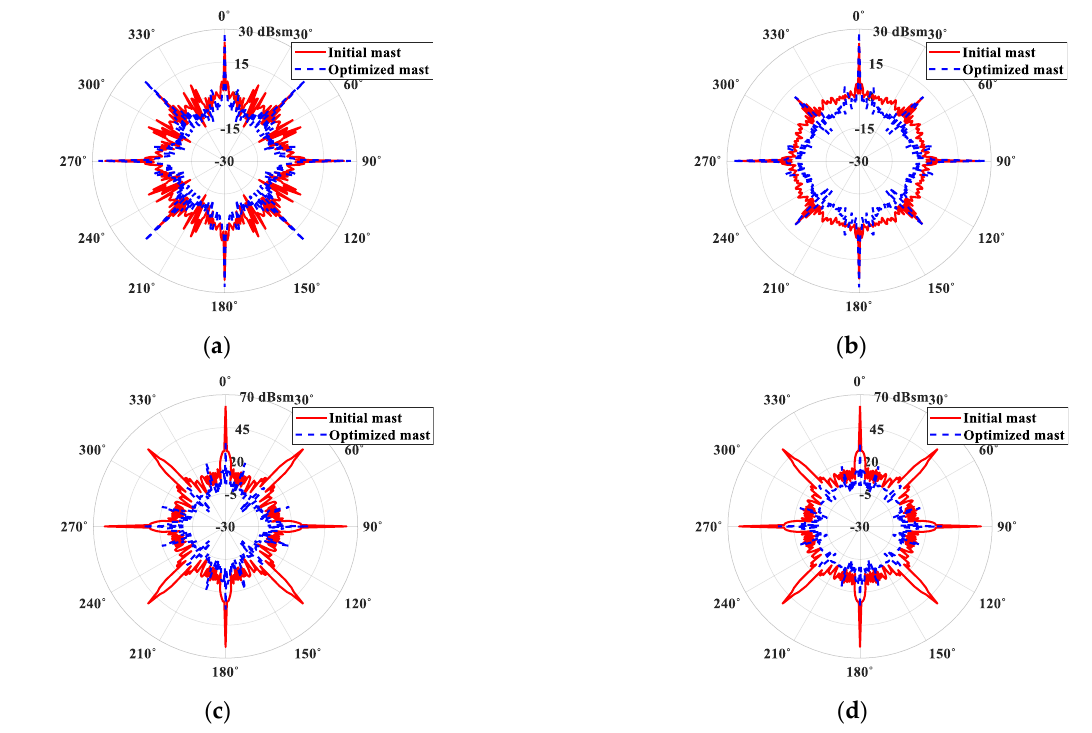
at an elevation angle of 10°.